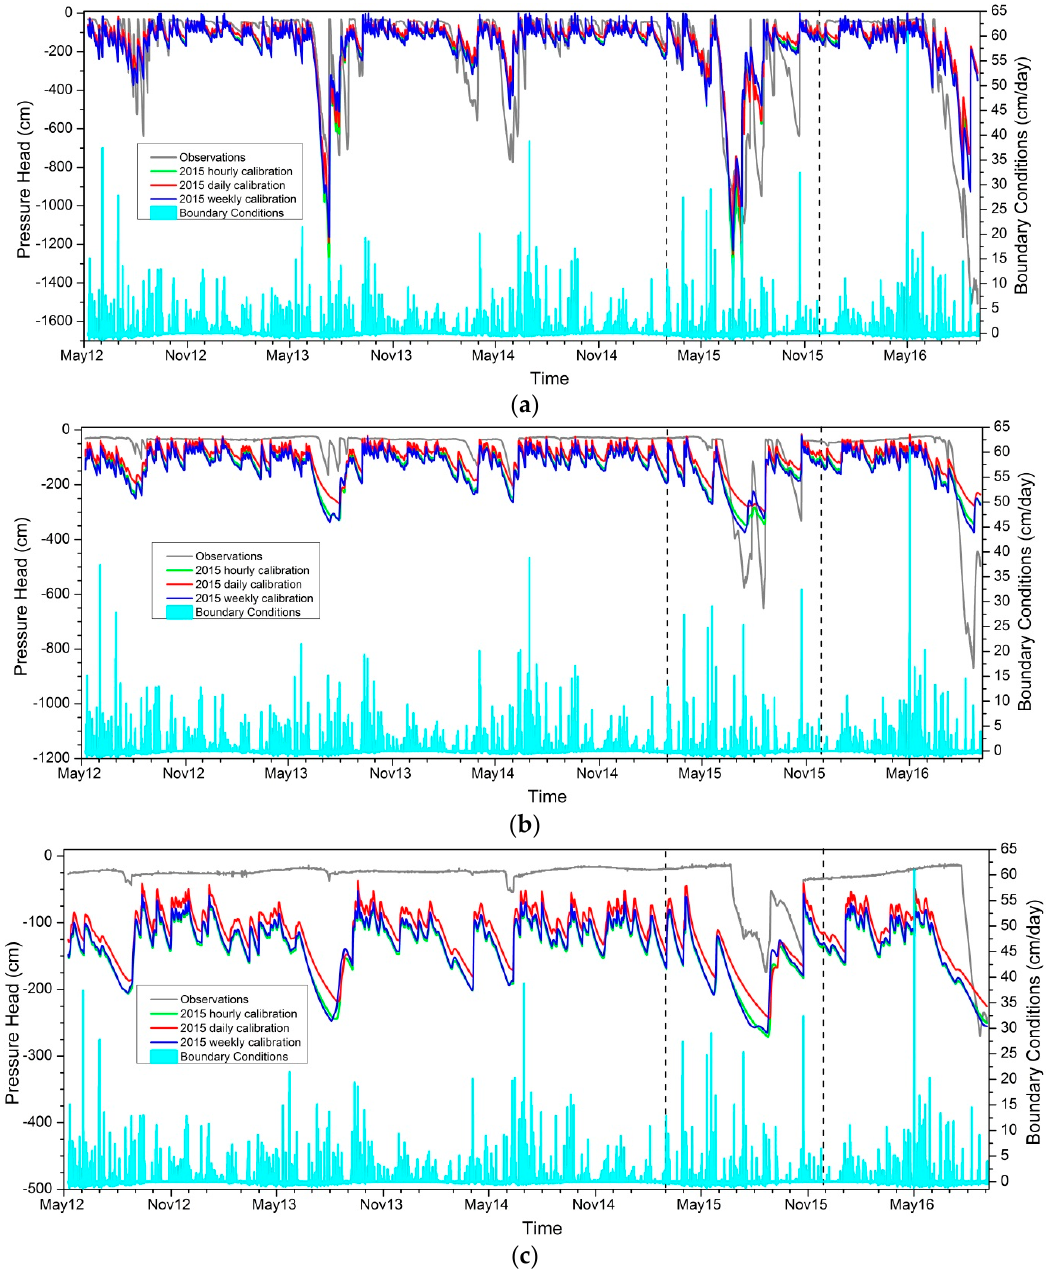
Figure 5. Pressure head values modeled for the period from May 2012 to September 2016. The model is calibrated using hourly, daily, and weekly data for the period from April to December 2015 (limited by vertical straight lines in the picture): pressure head values at depths of 42 cm ( a ), 71 cm ( b ), and 116 cm ( c ).